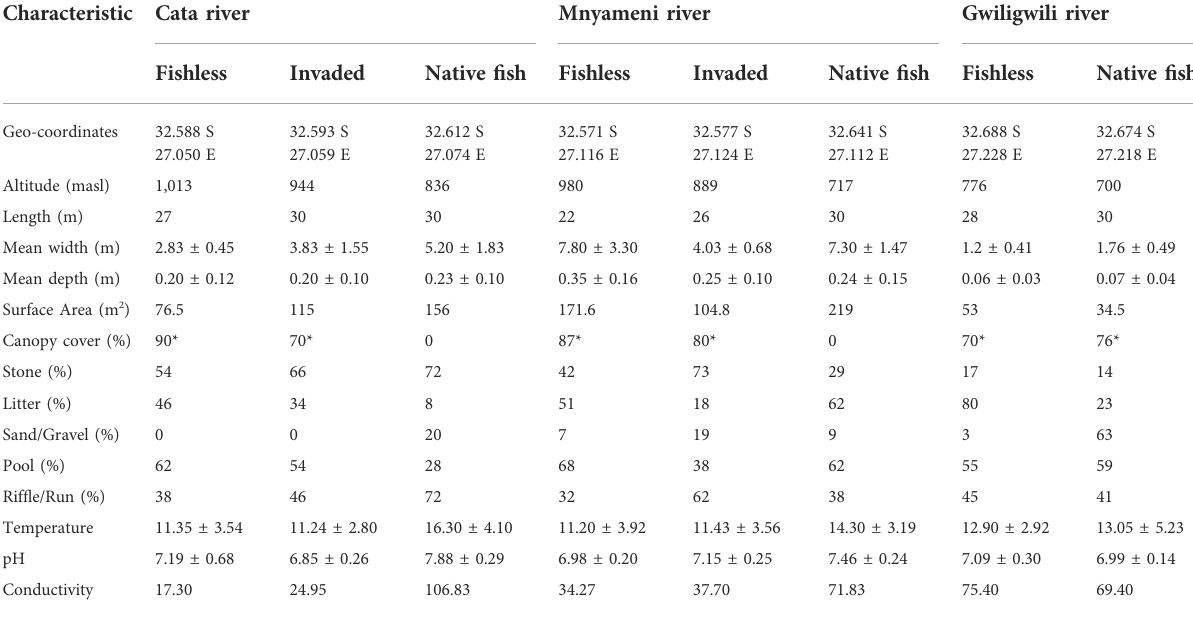
TABLE 1 Summary of the location, habitat and physicochemical characteristics (mean ± SD) for eight reaches sampled quarterly on three headwater tributaries of the Keiskamma River from July 2012 - April 2013. Values marked with an asterisk (*) indicate qualitative estimations. Characteristic Cata